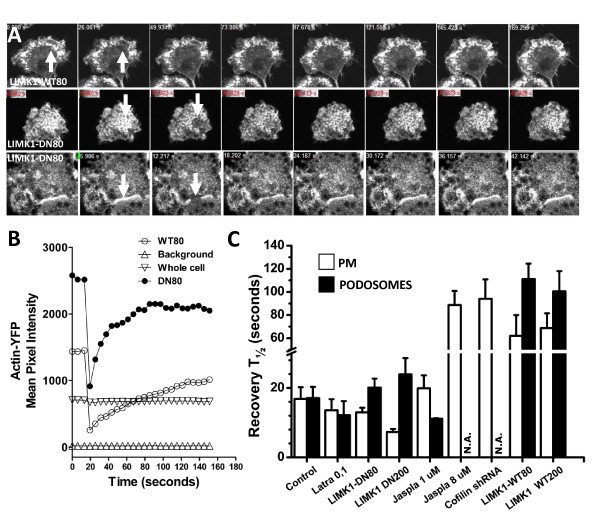
FRAP experiments reveal widely different actin recovery half-times in transduced Ra2 cells. Ra2 cell populations as indicated were superinfected with lentivectors expressing β-actin-YFP and used for FRAP. A) Panels (top, LIMK1-WT80 cells; two lower panels, LIMK1-DN80 cells) show time-lapse series of live Ra2 cells where the ROI bleached by the laser beam is indicated by arrows (the frame before and after bleach). In the top and middle row (LIMK1-WT80 and LIMK1-DN80 cells, respectively) the ROI covers podosomal structures, while the lower panel (LIMK1-DN80 cells) shows a ROI covering the opposing plasma membranes of two cells. B) Mean pixel intensity of β-actin-YFP fluorescence is depicted over time before and after bleach (bleach is at time point three) for LIMK1-WT80 cells, together with whole cell and background intensity (white symbols), and for LIMK1-DN80 cells (black). C) Mean pixel intensity of β-actin-YFP fluorescence was fitted to a curve for FRAP recovery to obtain the mean half-time of recovery for either plasma membrane or podosome ROI's for the indicated cell lines or drug-treated cells. The ordinate shows the recovery time in seconds and mean and SEM is based on FRAP curves obtained from at least ten different cell profiles.